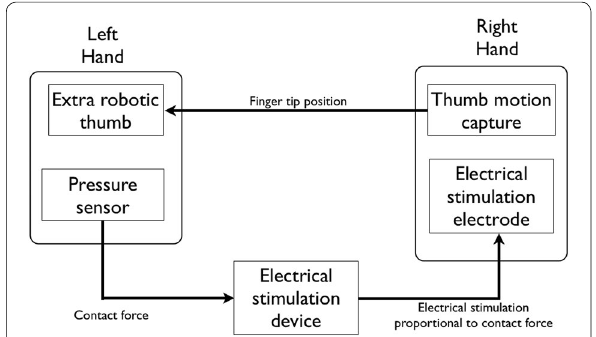
Fig. 4 Control diagram of the sixth finger system